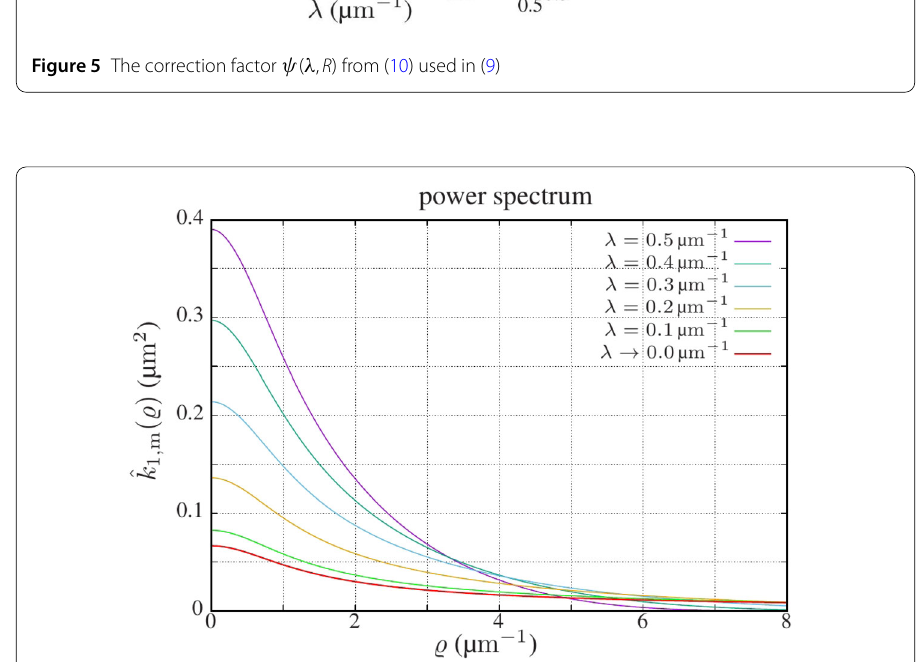
Figure 6 Graphs of the power spectrum ˆ k 1, m ( (cid:7) ) given by (9) for constant radius R = 1 μ m and varying λ